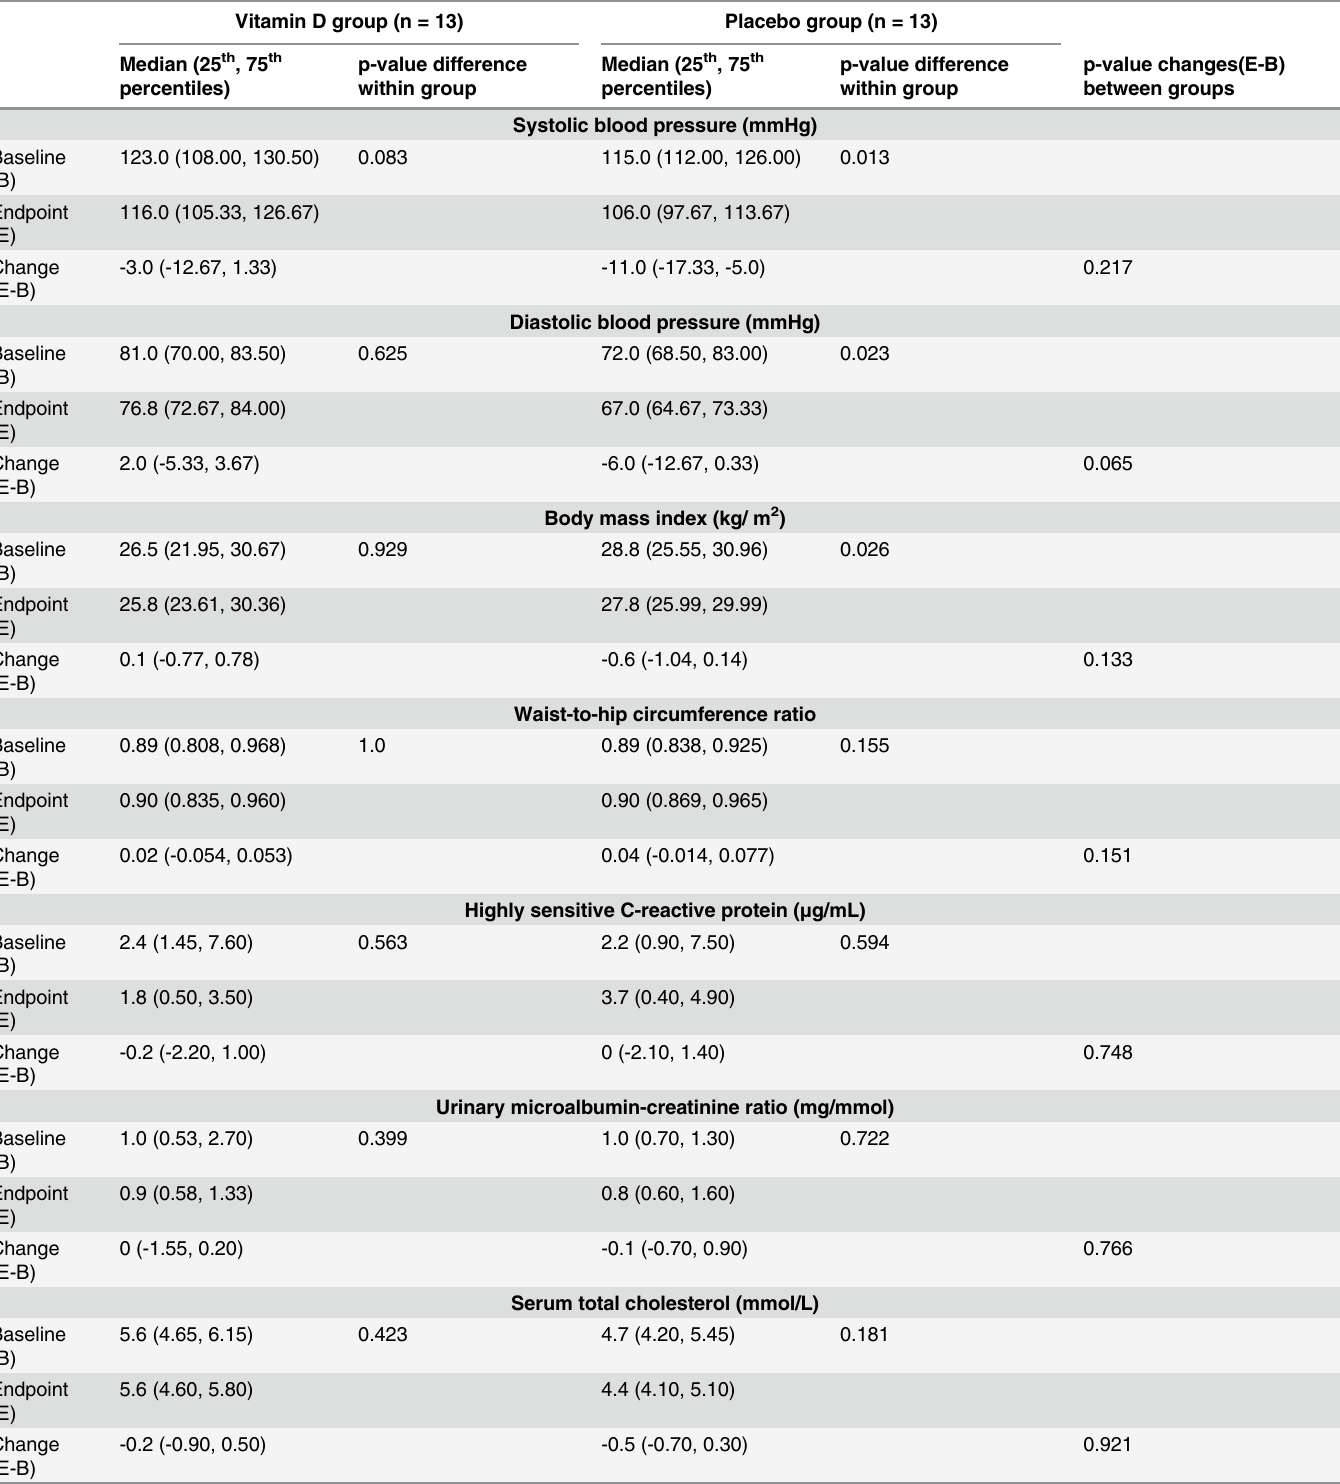
Table 3. Changes in markers of cardio-metabolic risk among women with former GDM in both interventional and placebo groups before and after